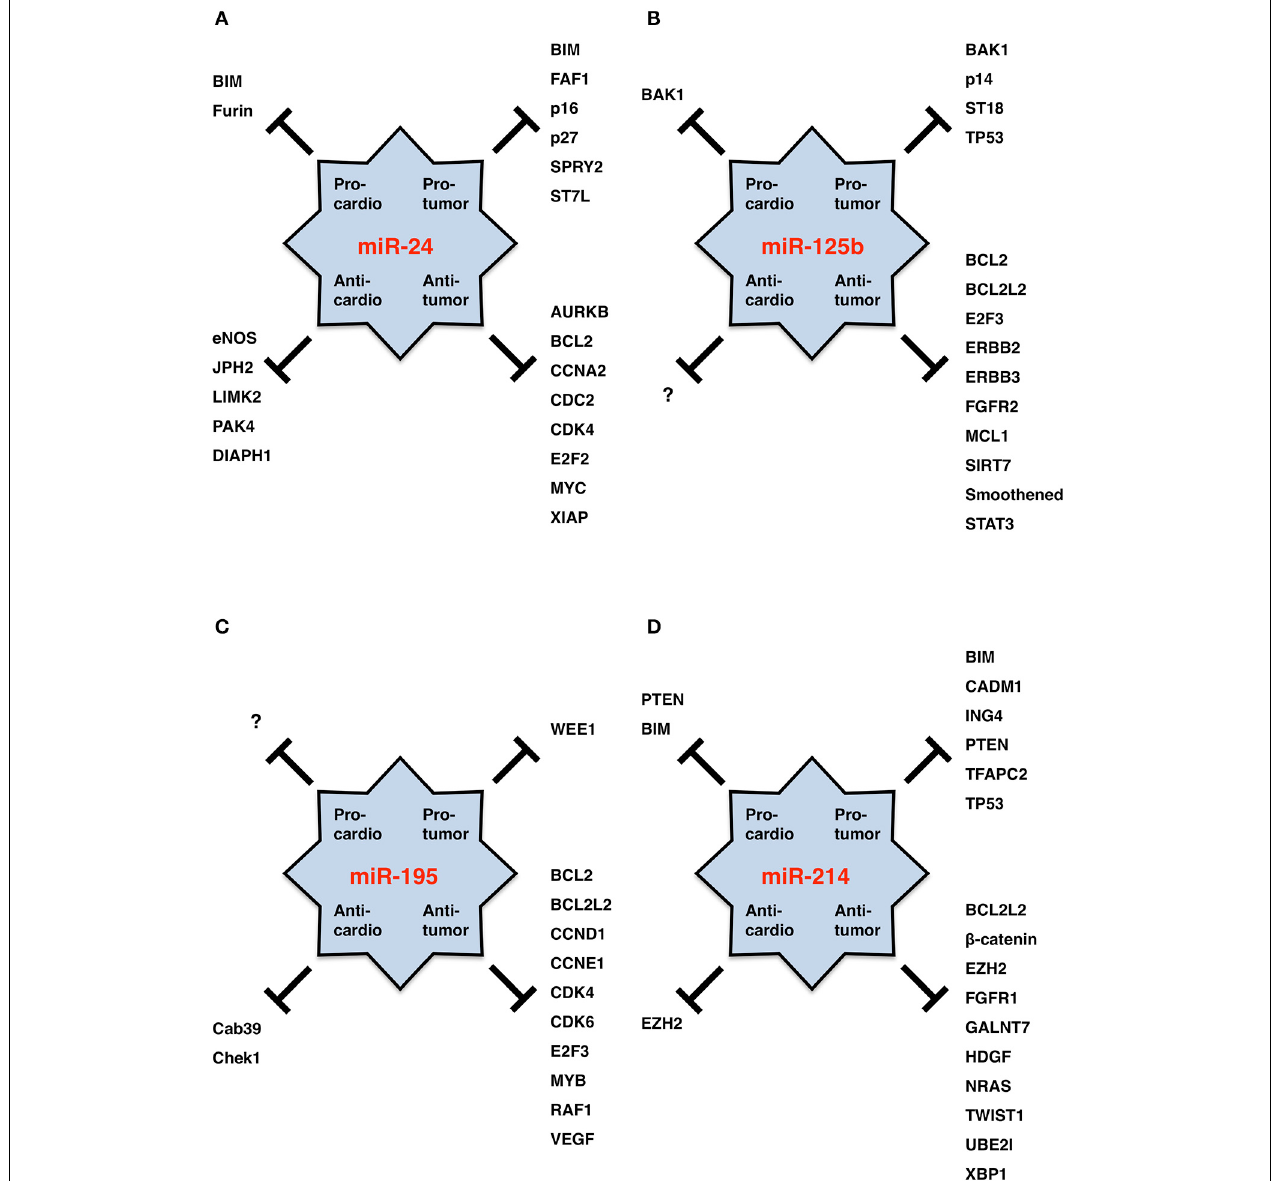
FIGURE 3 | miRNA functions in cardiology and oncology. (A) miR-24. (B) miR-125b. (C) miR-195. (D) miR-214. Targets for pro-tumor, anti-tumor, pro-cardio and anti-cardio functions of each miRNA are shown. miR-125b is a good cardio-miR that protects cardiomyocytes. miR-195 is a bad cardio-miR